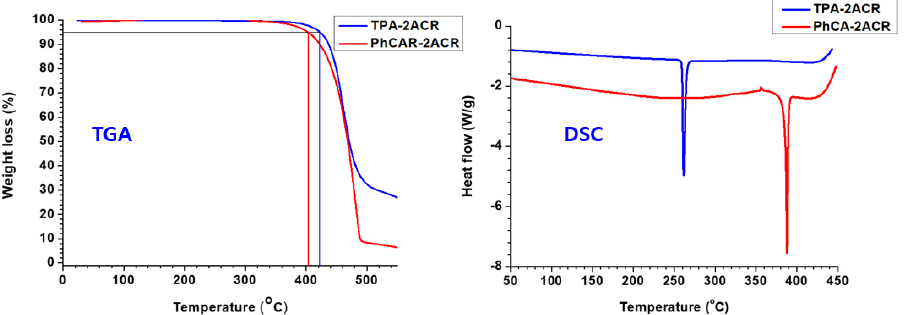
Figure 1. Thermal gravimetric analysis (TGA) and differential scanning calorimetry (DSC) of TPA ‐ 2ACR and PhCAR ‐ 2ACR.